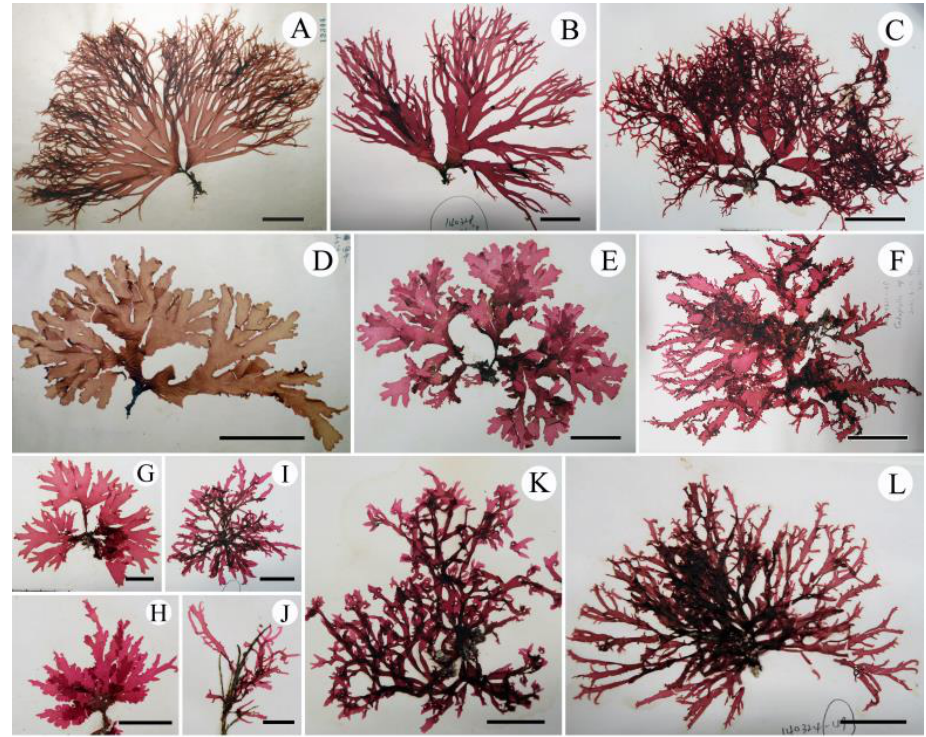
Figure 3. Acrosorium flabellatum Yamada. ( A ) Holotype specimens (SAP 12344) of A. flabellatum . ( B ) JN1403280085 from the type locality, Enoshima of Japan, phenotype as AF. ( C ) JN1307310149 from Yeosu of Korea, as AF + AC. ( D ) SAP 15293, holotype specimens of C. membranacea Yamada. ( E )